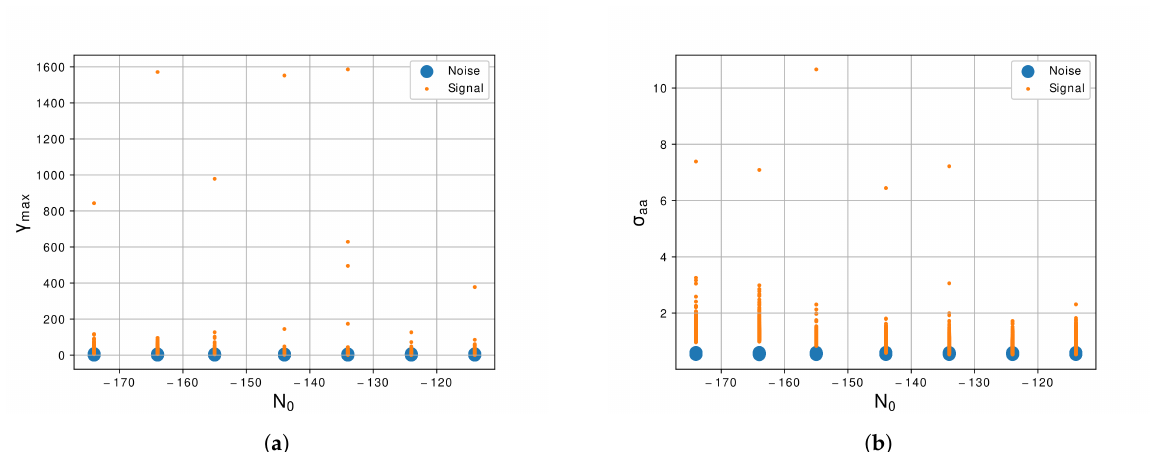
Figure 4. Graphic of the features ( a ) γ max , Equation (3), and ( b ) σ aa , Equation (4), with the variation of N 0 of − 114 dBm/Hz to − 174